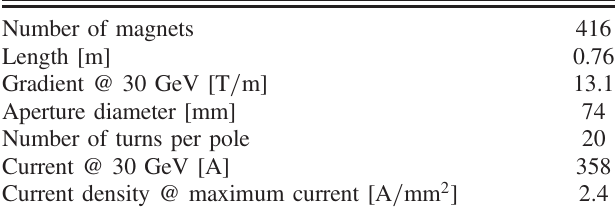
FIG. 3. Cross section of the SLC arc combined function dipoles.